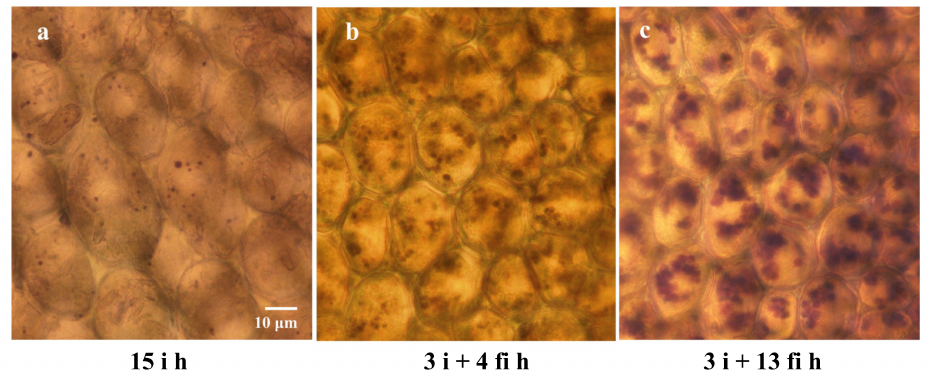
Figure 8. Light microscopy observation of starch grains stained by iodine in embryonic radicle cells after 15 h imbibition of seeds (15 i h: ( a )), and in the cells of embryonic axes kept 3 h (3 i + 4 fi h: ( b )) or 13 h (3 i + 13 fi h: ( c )) on wet filter paper after excision.